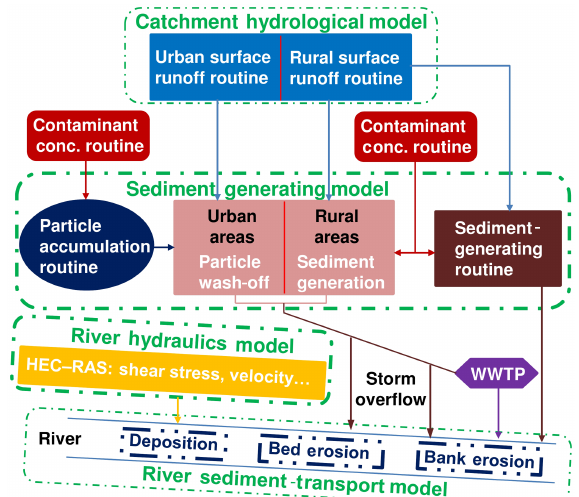
Figure 2. Integrated sediment transport model, consisting of a catchment-scale hydrological model, a river-hydraulic model, a sediment-generating model, and a river sediment-transport